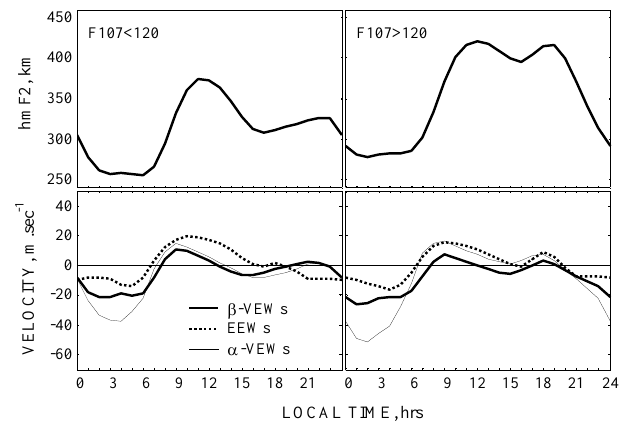
Fig. 8. The averaged F layer peak height, hmF2 (top panel), and corresponding equivalent winds based on Chapman- α ( α -VEWs) and Chapman- β ( β -VEWs) electron density profiles, and also empirical equivalent winds (EEWs) in September at two solar activity levels at Manila (bottom panel).